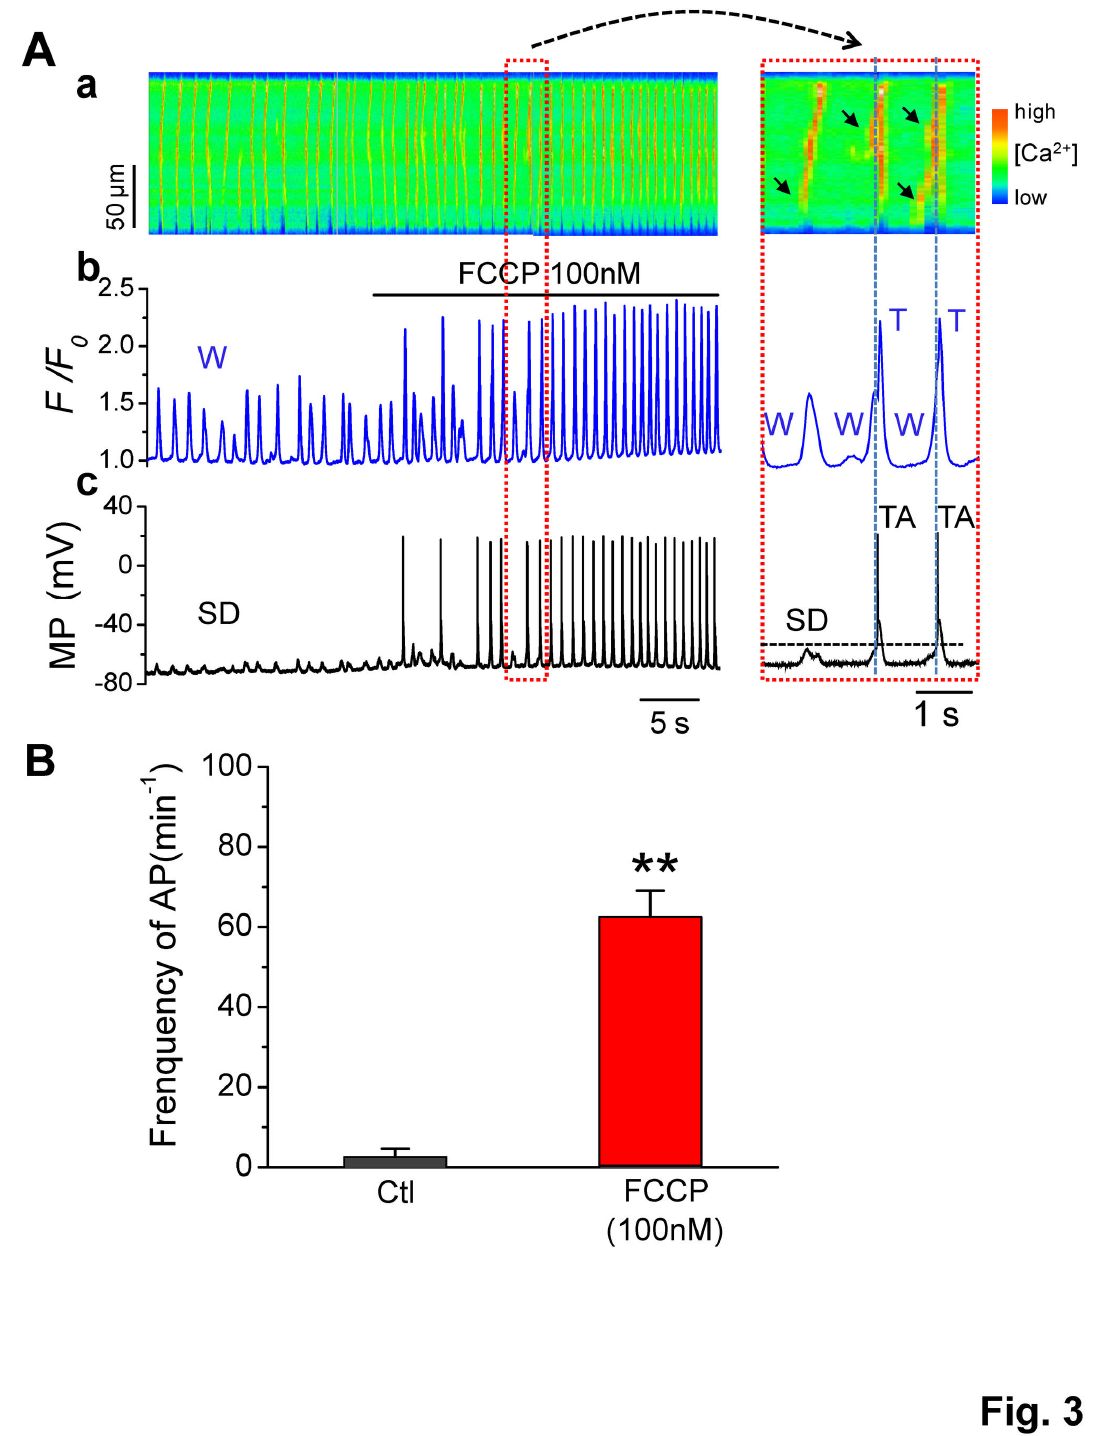
Figure 3. Action potentials (APs) were triggered by FCCP-enhanced Ca i2+ waves. A . A line-scan image along the long axis of the cell (A-a), whole-cell Ca fluorescence intensity (A-b), and membrane potential (A-c), were recorded simultaneously from a ventricular myocyte. CaWs (W) and sub-theshold depolarizations (SD) were exacerbated by FCCP (100 nM) so that triggered APs/ activities (TA) and Ca transients (T) were induced. B . Summary data showing that FCCP (100 nM) markedly increased the incidence of TAs (** p < 0.01 vs. control, n = 4). doi: 10.1371/journal.pone.0080574.g003 PLOS ONE |